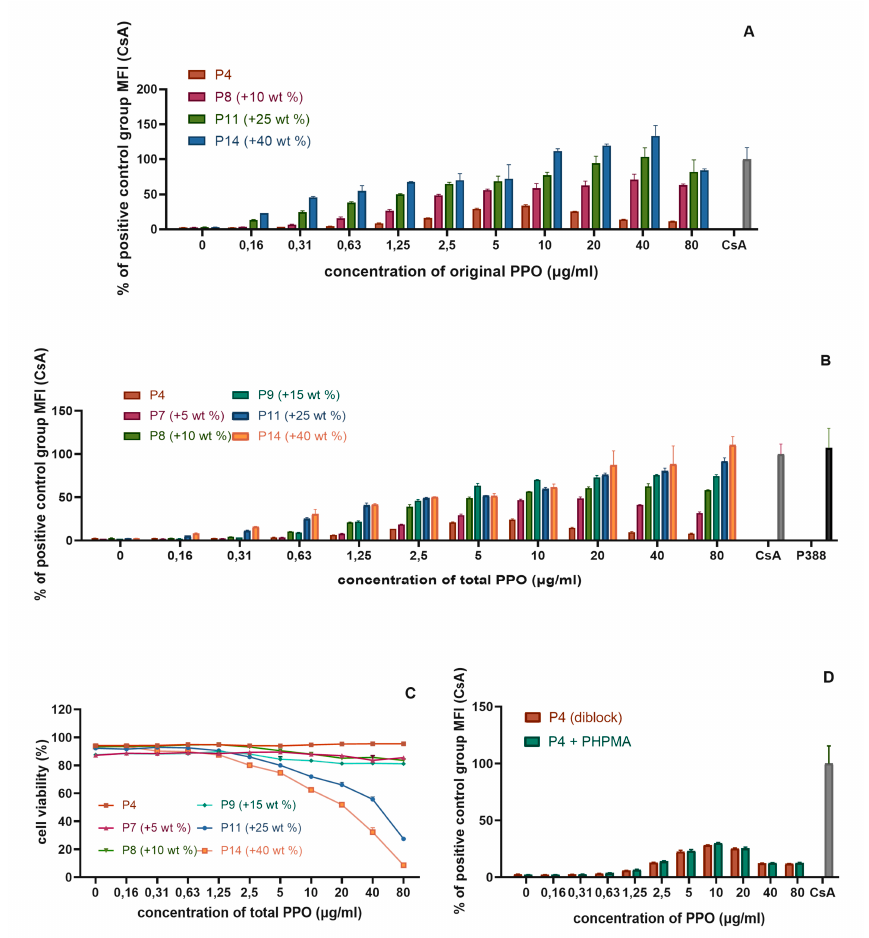
Figure 7. The P-gp inhibitory activity of PHPMA-PPO copolymers with different proportion of free PPO. The P388 / MDR cells were cultivated for 24 h with titrated concentrations of copolymer samples and their P-gp activity determined by calcein assay; 10 µ M cyclosporine A and sensitive P388 cells with calcein as the positive control ( A ) Samples resulting from adding various wt % of free PPO to the original sample P4, in which the total PPO content was determined by NMR. The x -axis indicates concentrations of PPO before loading of the free PPO, amount of the added free PPO as indicated in the legend; ( B ) Inhibitory activity of a series of copolymers (P4, P7, P8, P9, P11, and P14) with various ratios of PHPMA-PPO to the loaded free PPO. The x -axis indicates total content of PPO in the samples, which is the sum of the starting PPO in the original sample and the added free PPO; ( C ) Viability of P388 / MDR cells cultivated with titrated concentrations of copolymer samples with various ratio of PHPMA-PPO to the loaded free PPO as shown in Figure 7B. Viable cells (Hoechst 33258-negative) were determined by flow cytometry. ( D ) Inhibitory activity of the mixture of PHPMA-PPO copolymer and added free PHPMA in a molar ratio of 1:1.